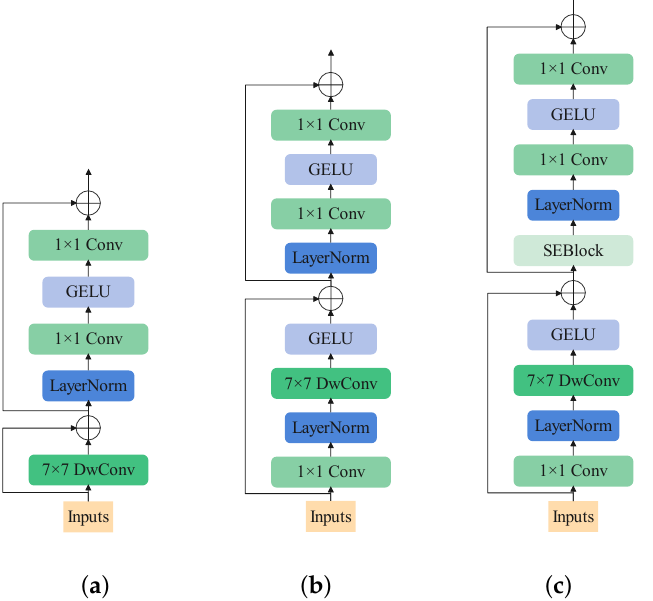
Figure 6. The order of designing the EmbedFormer block. ( a ) The structure of the first designed block. ( b ) The structure of the second designed block. ( c ) The structure of EmbedFormer